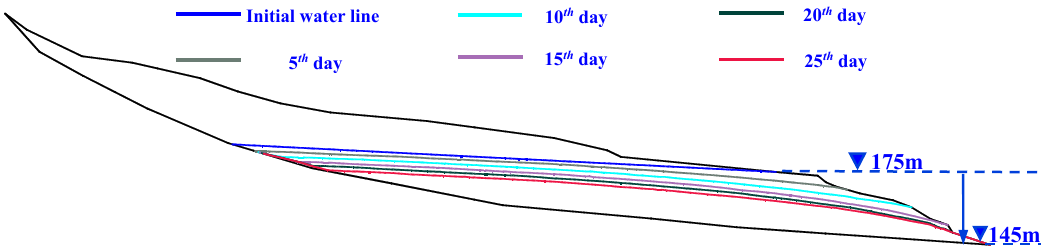
Figure 14. Dynamic variation process of infiltration line with k r = 1 and α = 0° of sandy slope